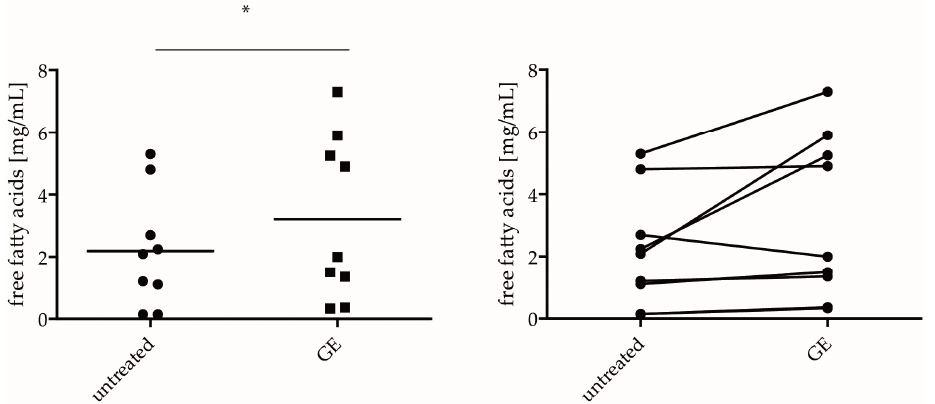
Figure 3. GE increases the amount of fatty acids in vitro. hPKs were treated with 200 µ g/mL GE for